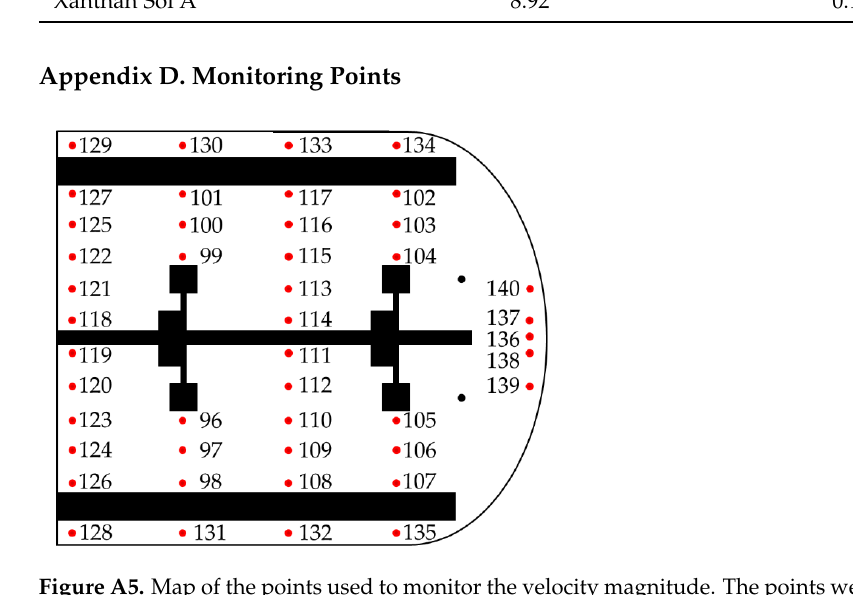
Figure A6. Alginate aggregates re-suspended from samples of culture #1 taken after ( a ) 30 h and ( b ) 51 h since the inoculation. Figure A7. Alginate aggregates re-suspended from samples of culture #2 taken at different times.